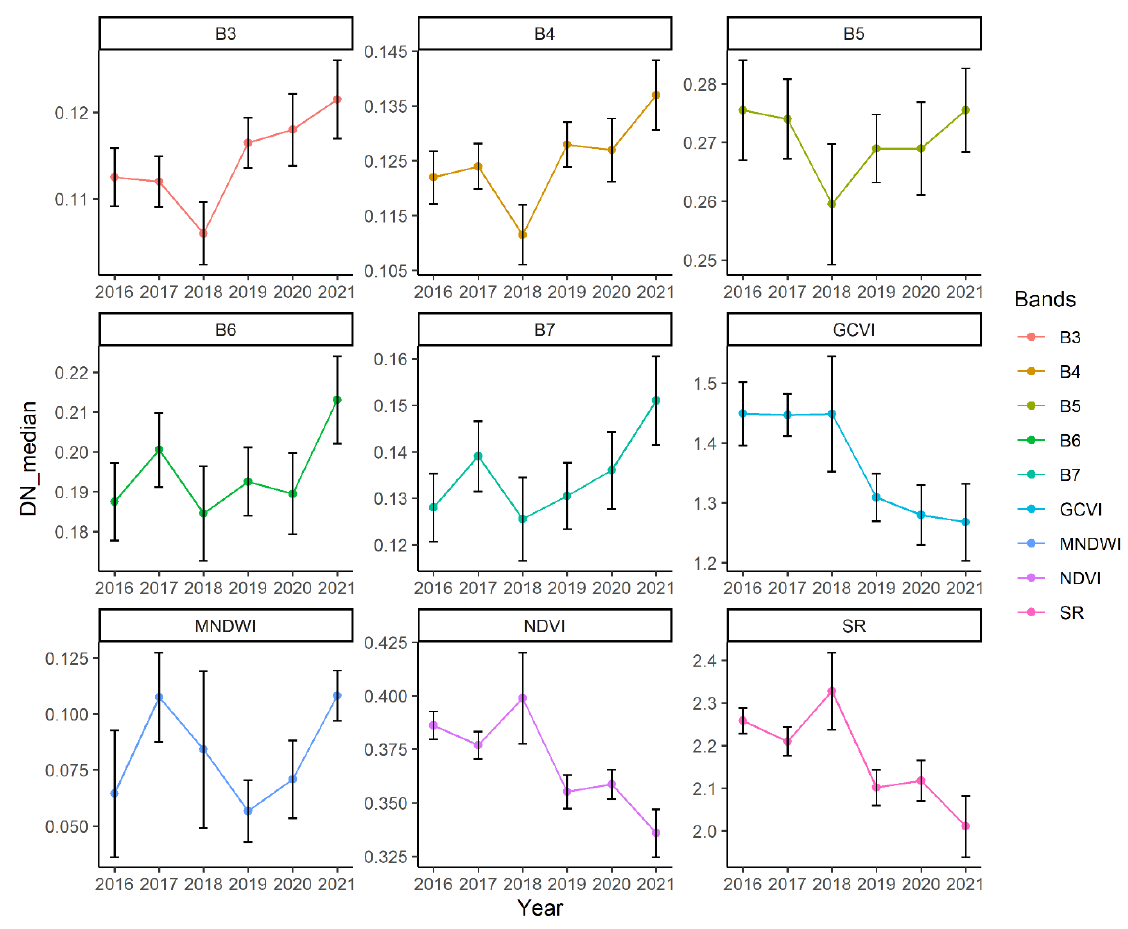
Figure 6. Example of differences in Landsat satellite single image scenes (variance bars represent all images between 2014 and 2021), and annual median composite images (line) for variables used in habitat models derived from image spectra. B3–B7 Refer to wavelengths (central wavelength) ‘B3 (Green—560 µ m)’, ‘B4 (Red—665 µ m)’, ‘B5 (Vegetation Red Edge—705 µ m)’, ‘B6 (Vegetation Red Edge—740 µ m)’, ‘B7 (Vegetation Red Edge—783 µ m). GCVI, MNDWI, NDVI and SR refer to the indices derived from the image spectral bands. (See Figure S9 for example of corresponding Landsat images and Figure